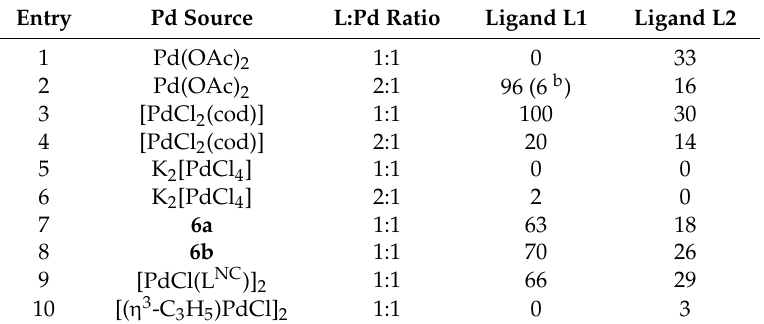
Table 1. Results of the screening experiments with various Pd precursors and donors L1 and L2 a . Entry Pd